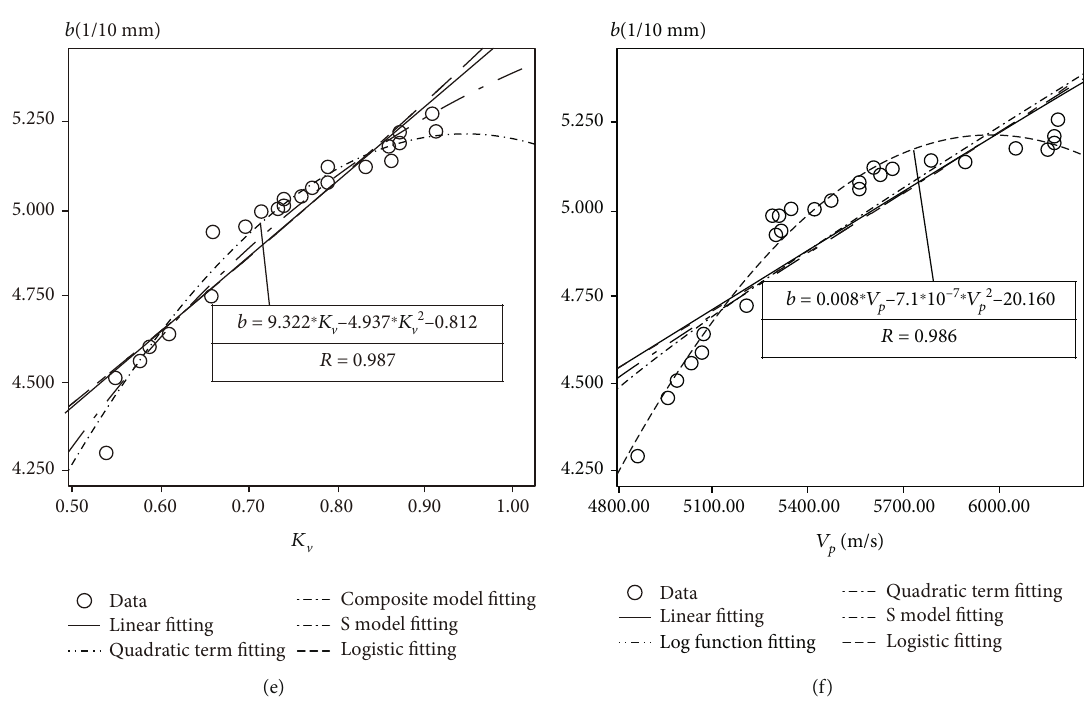
Figure 4: Abrasion performance and mechanical parameter diagram. Table 4: Results of granite physical mechanical parameters and Table 6: The multifactor regression analysis model coe ffi cient of abrasion performance fi tting. abrasion